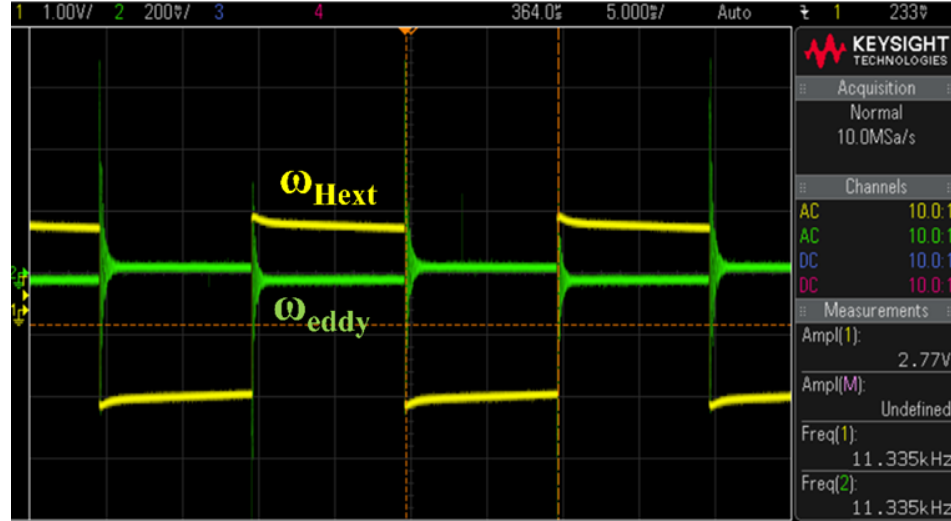
Figure 12. Simulation result of the metal (clip) detected using pulse signal.